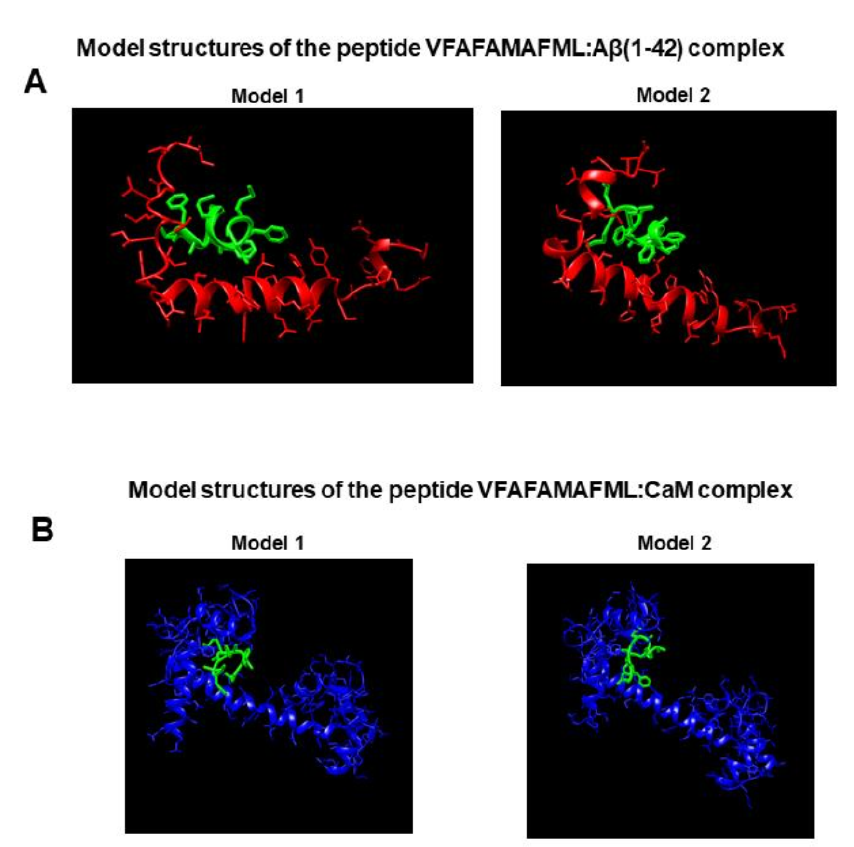
Figure 8. Highest-rank model structures of the complexes between the VFAFAMAFML peptide and A β (1–42) and CaM saturated with Ca 2+ generated in silico by docking using the CABS-dock web server. ( A ) Model structures of the peptide VFAFAMAFML:A β (1–42) complex. ( B ) Model structures of the peptide VFAFAMAFML:CaM complex. The two model structures with higher cluster density are shown for each complex, i.e., the two most probable structures yielded by the CABS-dock web server. Peptide backbones and side chains of amino acids are shown. The VFAFAMAFML peptide is colored in green, A β (1–42) in red, and CaM in blue. See the Materials and methods section for more